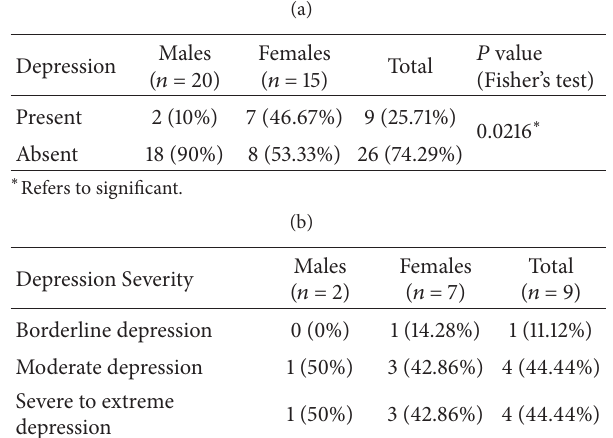
Table 2: (a) Gender differences in prevalence of depression on BDI. (b) Gender differences in severity of